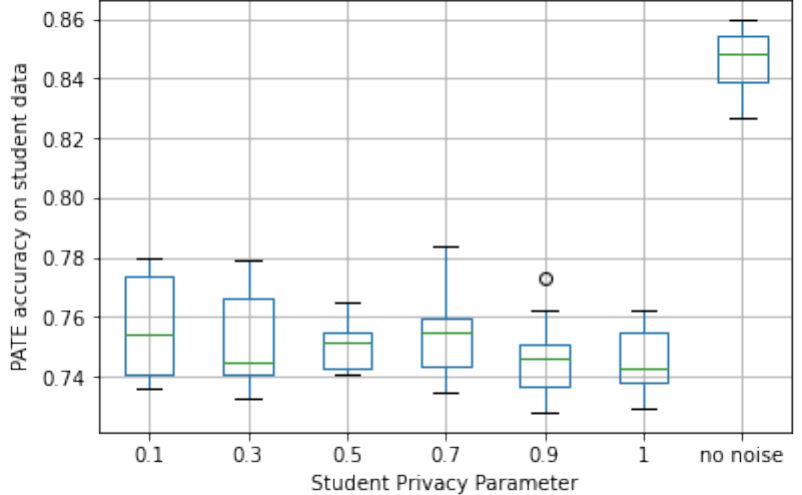
Figure 9. PATE accuracy evaluated on student data by privacy parameter ρ in ECG dataset.